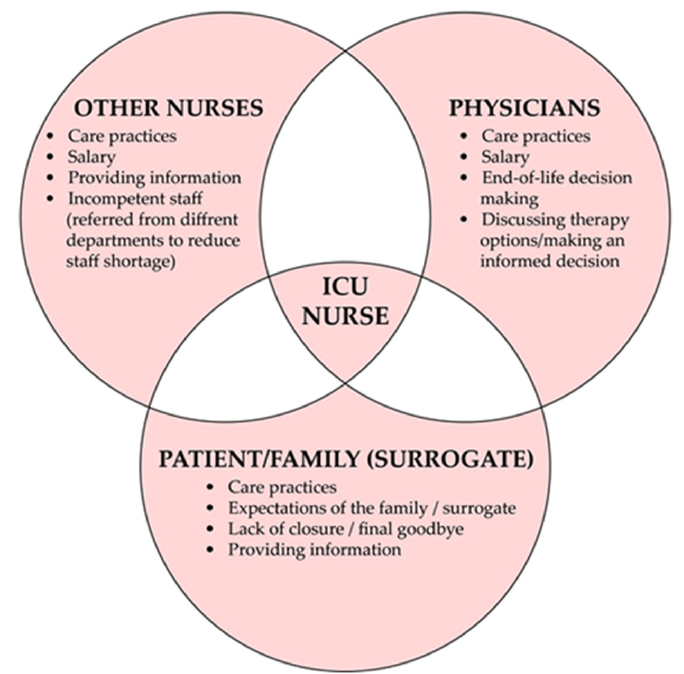
Figure 2. Common sources of conflicts in ICUs.